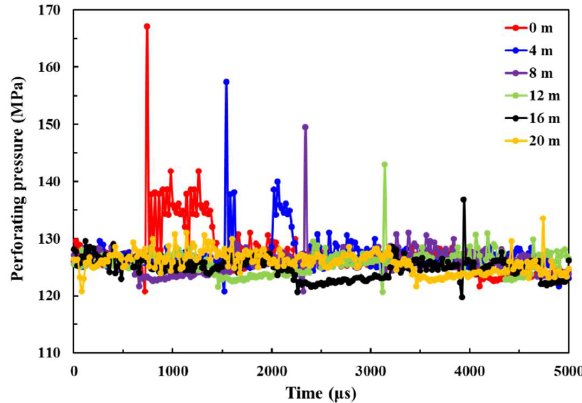
Figure 9. Pressure-time curves at different positions of the wellbore.